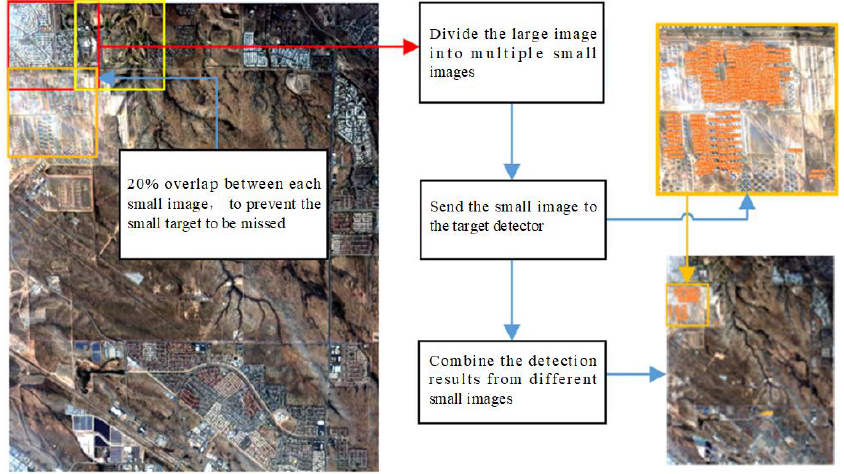
Figure 8. An example of the image segmentation detection method.